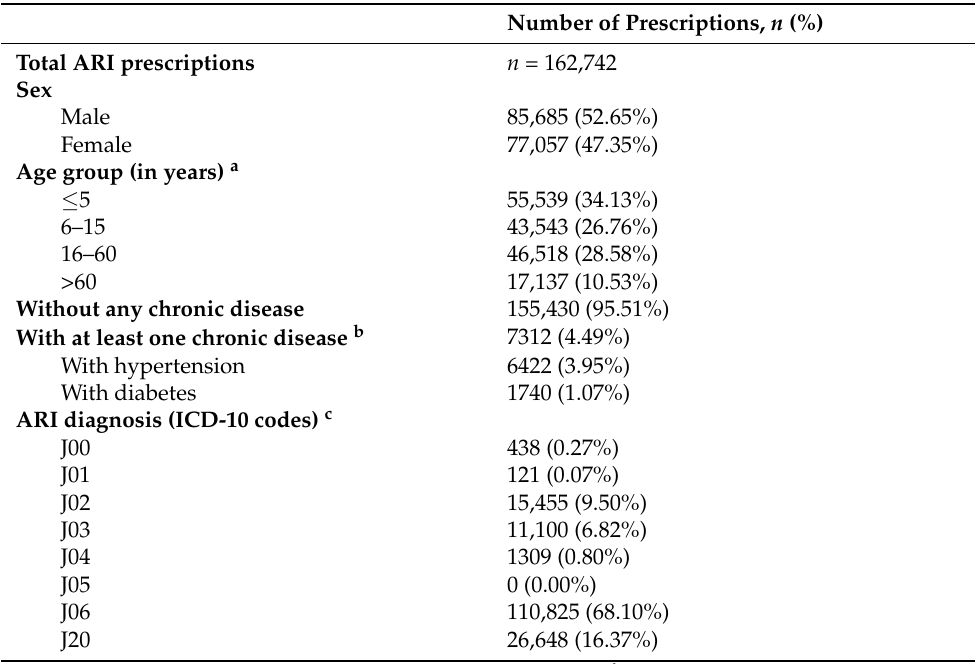
Table 1. General characteristics of patients with acute respiratory infections (ARIs) in the eligible prescription